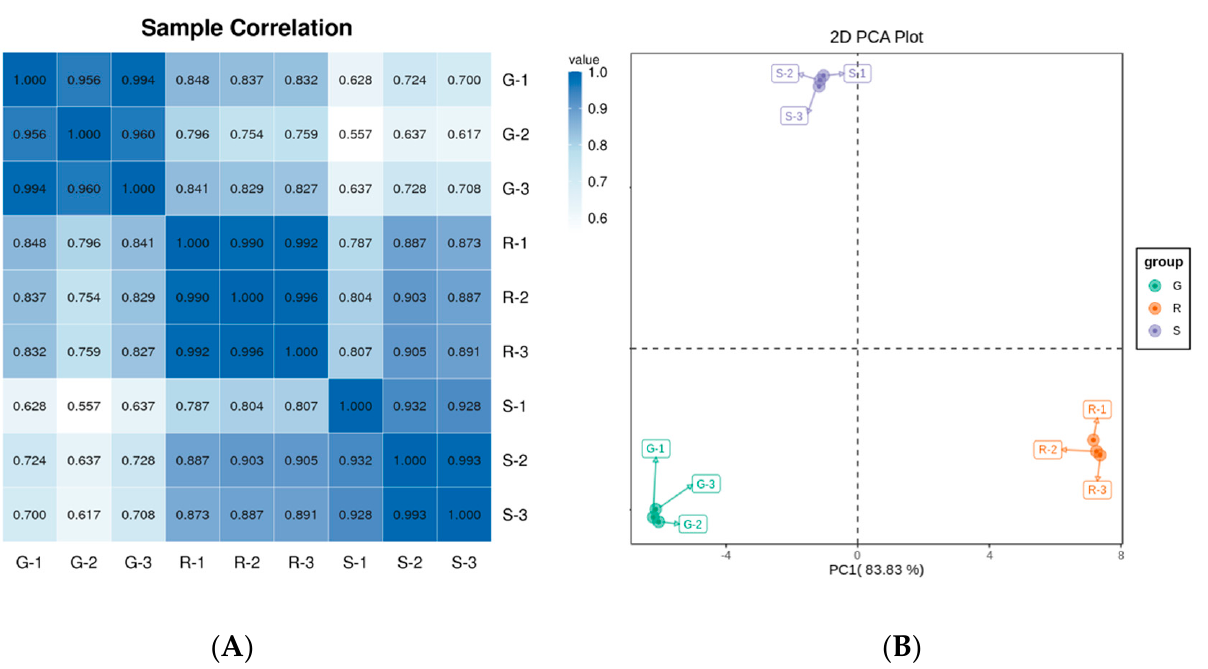
Figure 3. Sample correlation analysis and principal component analysis of sepals in different roselle cultivars. ( A ) Sample correlation analysis: Closeness of the correlation coefficient to 1 indicates the correlation strength of the cultivars. ( B ) The three roselle cultivars were separated from each other and the biological repeats were clustered together.